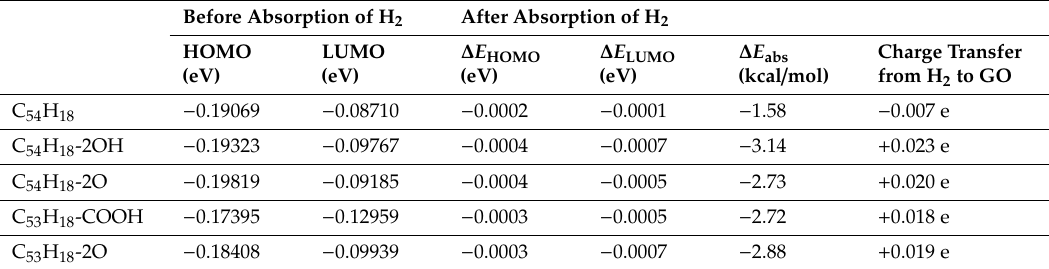
Table 1. Summary of the highest occupied molecular orbital (HOMO) energy level, the lowest unoccupied molecular orbital (LUMO) energy level, the shift of HOMO ( ∆ E HOMO ) and LUMO ( ∆ E LUMO ) energy level and cluster total energy before and after adsorption of molecular hydrogen. Charge transfer from H 2 to GO indicates the sum of the Mulliken charge of the GO model. Before Absorption of H 2 After Absorption of H 2 ∆ E ∆ E ∆ E HOMO LUMO Charge Transfer HOMO LUMO abs (eV) (eV) (eV) (eV) (kcal / mol) from H 2 to GO C 54 H 18 − 0.19069 − 0.08710 − 0.0002 − 0.0001 − 1.58 − 0.007 e C 54 H 18 -2OH − 0.19323 − 0.09767 − 0.0004 − 0.0007 − 3.14 + 0.023 e C 54 H 18 -2O − 0.19819 − 0.09185 − 0.0004 − 0.0005 − 2.73 + 0.020 e C 53 H 18 -COOH − 0.17395 − 0.12959 − 0.0003 − 0.0005 − 2.72 + 0.018 e C 53 H 18 -2O − 0.18408 − 0.09939 − 0.0003 − 0.0007 − 2.88 + 0.019